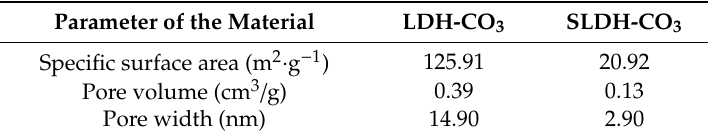
Table 2. Obtained results from specific surface area and pore parameters from the Brunauer-Emmett- Obtained results from specific surface area and pore parameters from the Teller (BET) and the Barrett–Joyner–Halenda (BHJ) for the ochre-based LDH (LDH-CO 3 ) as well as Brunauer-Emmett-Teller (BET) and the Barrett–Joyner–Halenda (BHJ) for the ochre-based LDH the synthetic one (SLDH-CO 3 ). (LDH-CO 3 ) as well as the synthetic one (SLDH-CO 3